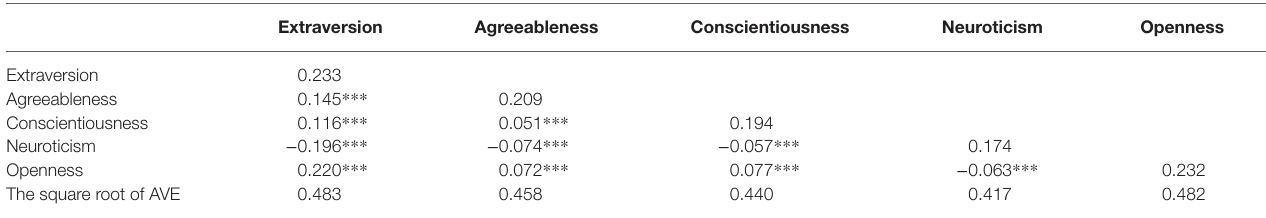
TABLE 1 | Discriminant validity